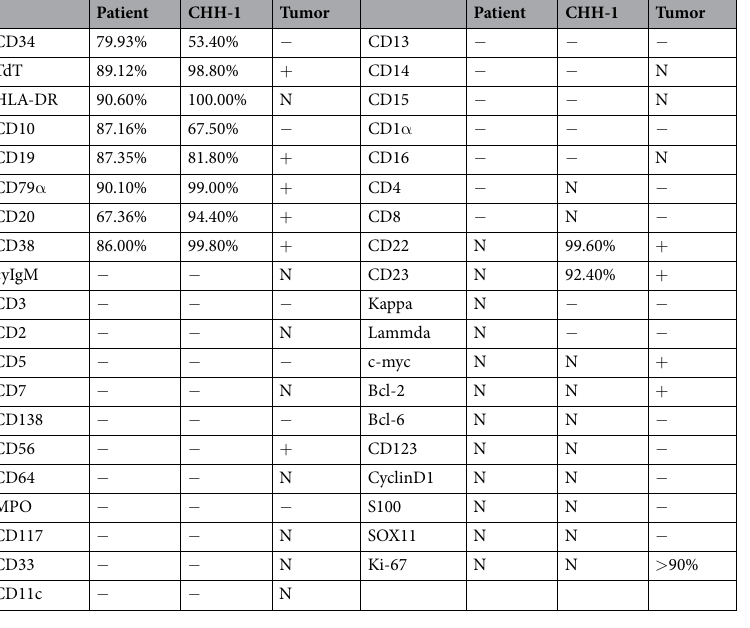
Table 1. Immunophenotypic marker profiles of the original patient leukemia cells, CHH-1 cells and the tumor formed by CHH-1 cells. For the original patient leukemia cells and CHH-1 cells, the values shown are the means of percent positive cells in three tests analyzed by flow cytometry. For the tumor formed by CHH-1 cells, the qualitative results are detected by immunohistochemistry. CD: cluster of differentiation;